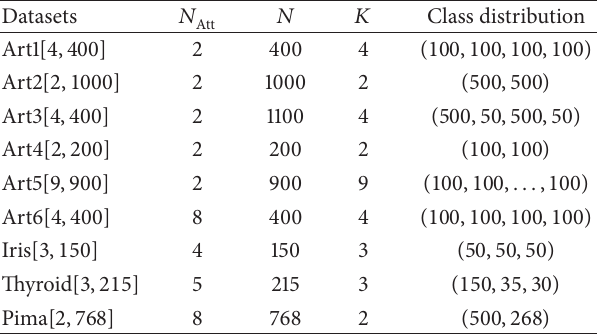
Table 2: Main characteristics of artificial and real databases used in our